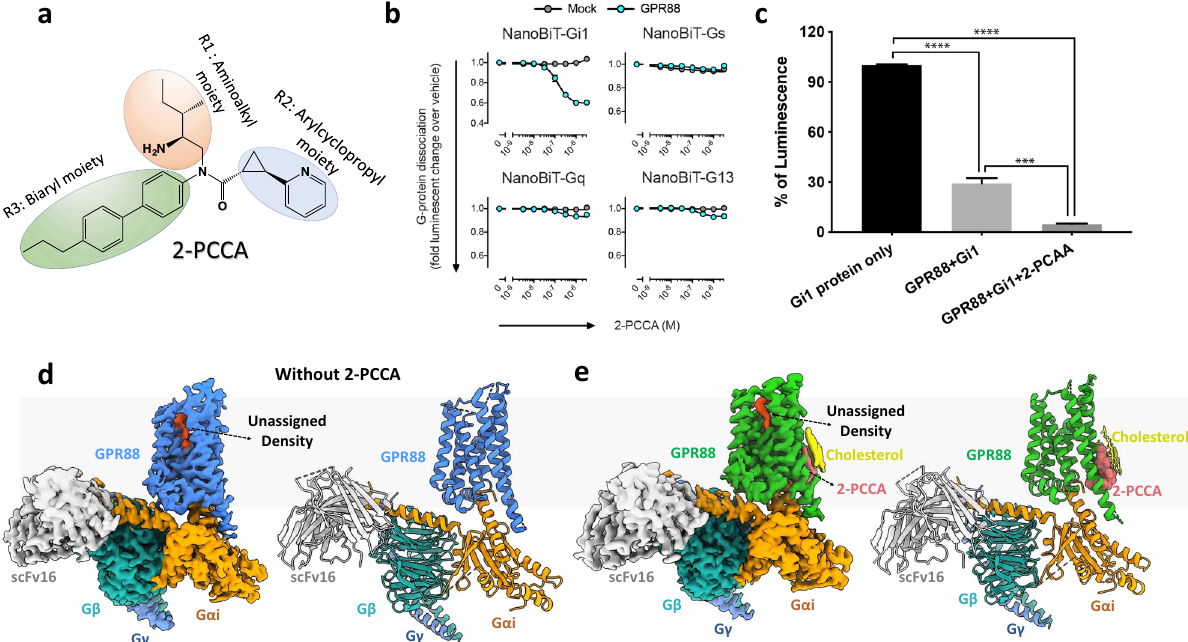
Fig. 1 Cryo-EM structures of GPR88-Gi1 in the apo and 2-PCCA-bound forms. a The chemical structure of 2-PCCA. b NanoBiT G-protein dissociation assay. Concentration – response curves of the G-protein dissociation signals for the indicated G-protein members. Symbols and error bars represent mean and s.e.m. of 3 (Gs), 4 (Gq, G13), and 6 (Gi1) independent experiments, each performed in duplicate. c Coupling of apo-state GPR88 or 2-PCCA bound GPR88 with Gi1 measured by GTPase Glo assay using puri fi ed proteins in detergent micelles. Error bars denote mean and s.e.m. of fi ve independent experiments with repeats in triplicate. Statistical analyses were performed using the ordinary one-way ANOVA. *** p < 0.001; **** p < 0.0001. d , e Cryo-EM maps and structural models of GPR88-Gi1 signaling complex in the absence ( d ) or presence ( e ) of